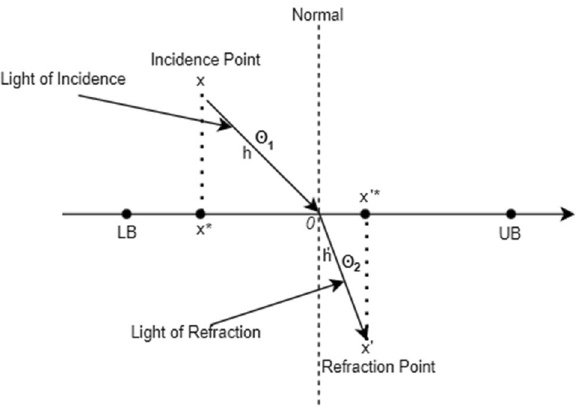
Figure 2. Fundamentals of light refraction.